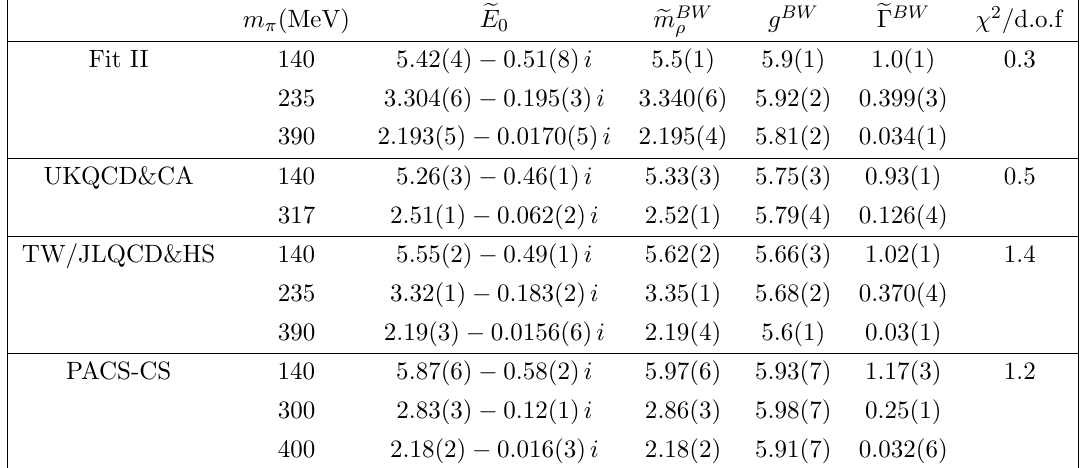
Table 5 . Pole positions obtained in the IAM, E 0 , and BW parameters m BW obtained from the re(cid:12)t of the IAM solution to the BW formula in eq. (B.1) normalized to the pion mass, i.e., e E 0 stands for E 0 =m (cid:25)